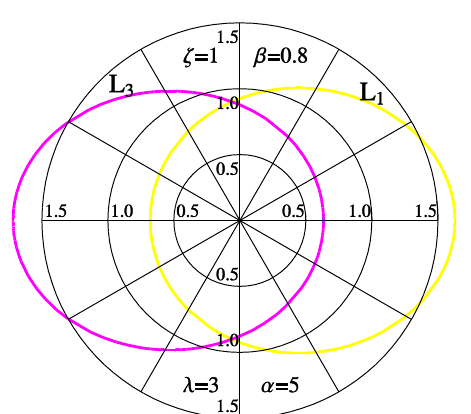
Fig. 4. The distribution of the modulus values of the total magnetic field outside of the conductors of the outer phases of a three-phase single-pole flat high-current busduct with symmetrical currents I 1 , I 2 and I 3